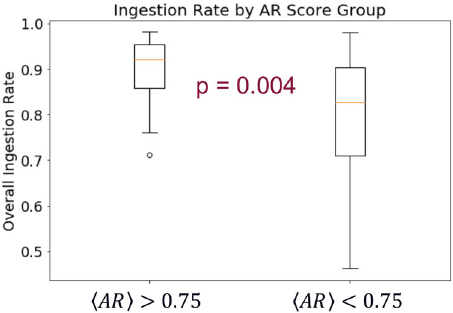
Fig. 5 Patient-level AR versus overall ingestion rate. Boxplot of the overall ingestion rate for these patients divided at the median 〈 AR 〉 value of 0.75 into high- and low- 〈 AR 〉 groups. Here, the center lines of the boxplots represent the median value, the box limits represent the upper and lower quartiles, the whiskers extend to 1.5 times the interquartile range, and outliers are represented by open circles. Note that only patients with at least 5 weeks of analyzable data were included in this sample. The high- 〈 AR 〉 group has high overall ingestion rates while the low- 〈 AR 〉 group has a much wider distribution of ingestion rates. The Mann – Whitney U test p -value between these groups is 0.004. Note that there is signi fi cant differentiation between the groups for a range of 〈 AR 〉 threshold values (see “ Discussion ”